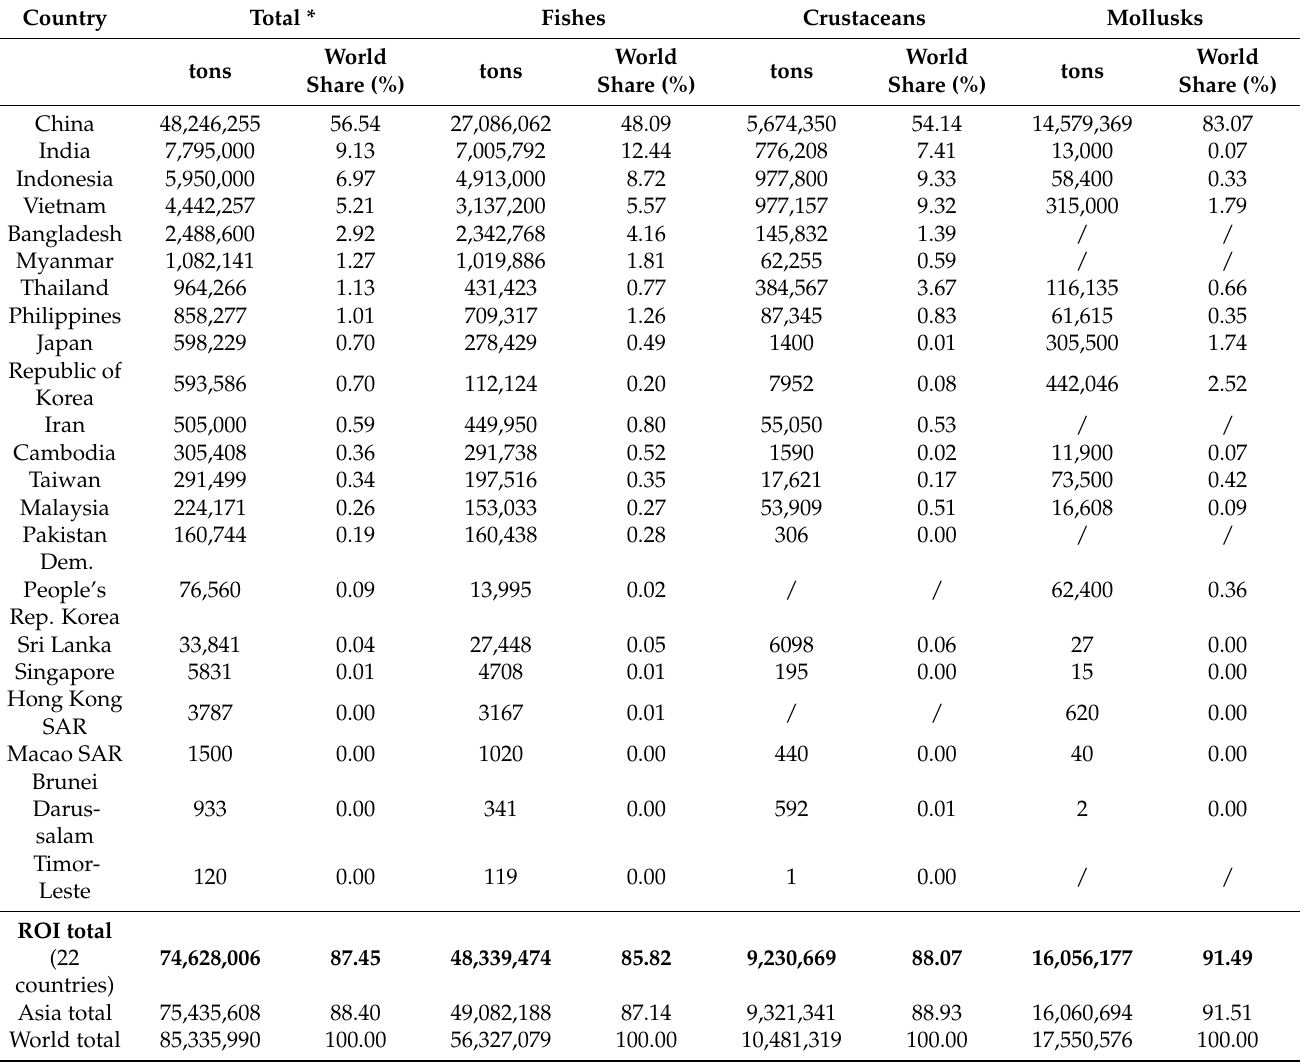
Table 3. Aquaculture production (excluding aquatic plants) for all countries in the study region and respective shares of the main aquatic product groups in 2019. Data source: